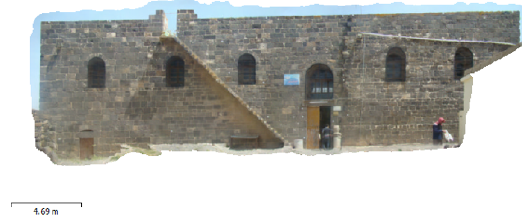
Figure 13. Orthophoto of Al Omari Mosque (the results of the dense matching are not presented in this paper)